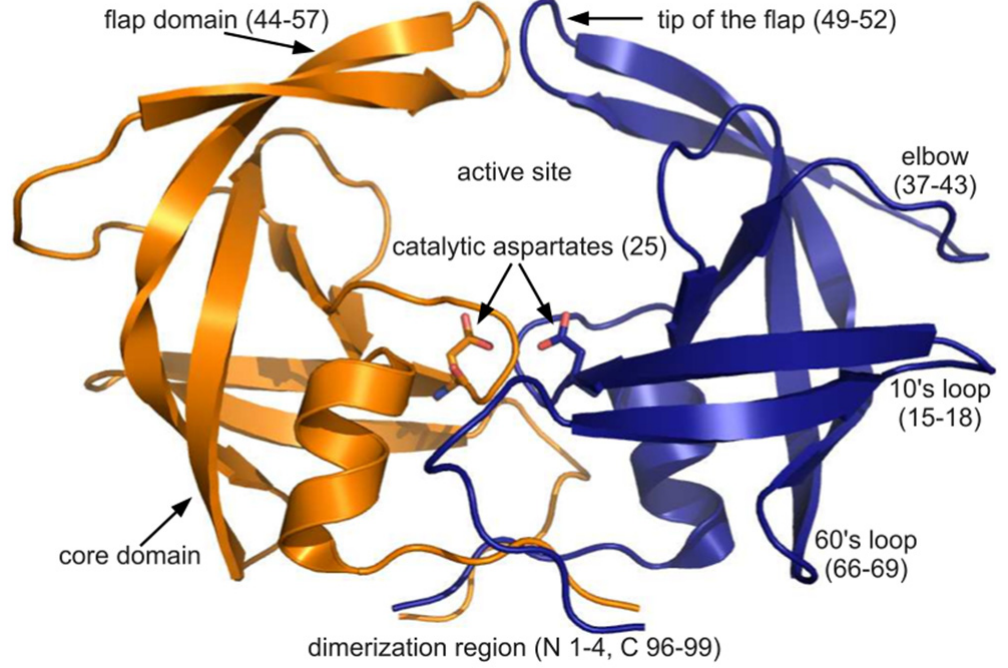
Figure 1. The PR dimer. Cartoon diagram of PDB ID 3hvp showing the monomers in orange and blue. Regions of PR structure are labeled, and relevant residue numbers are given in parenthesis. Rendered using PyMOL.